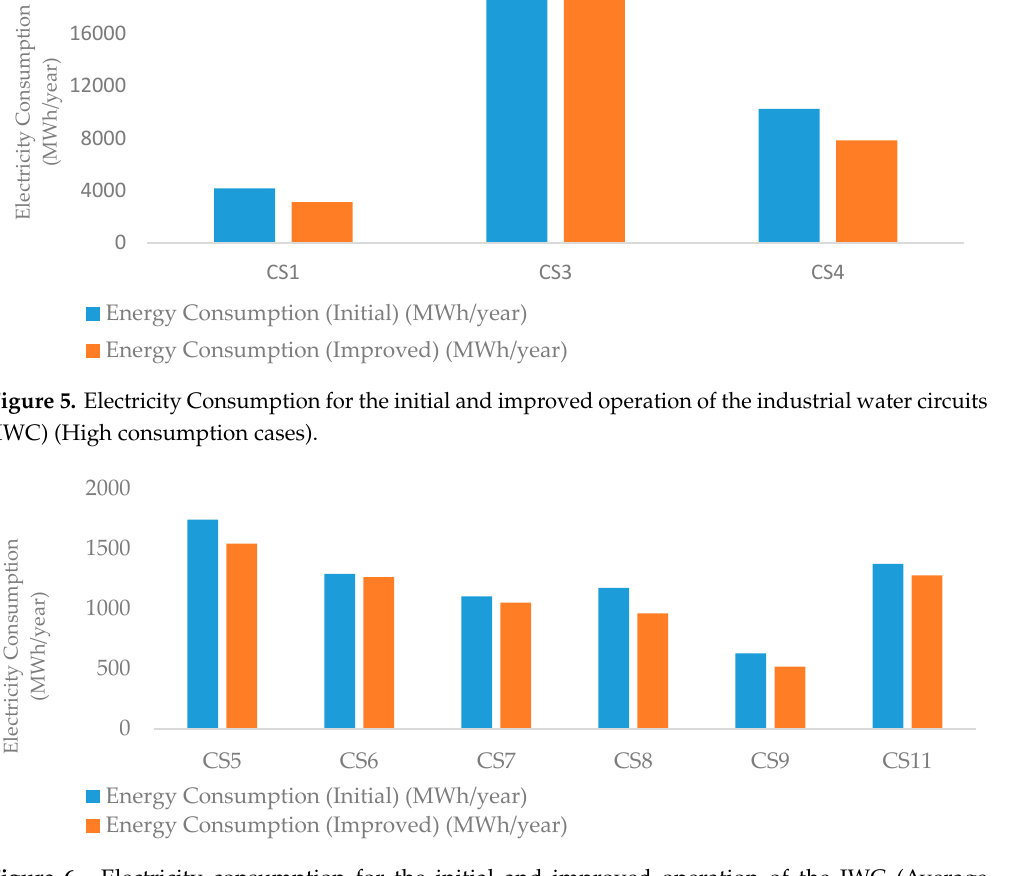
Figure 7. Electricity consumption for the initial and improved operation of the IWC (Low consumption cases). In the case ‐ studies with high electricity consumption (CS1 and CS4), appreciable savings have been achieved. On the other hand, the implementation of all the measures in CS3 has not allowed significant reductions of the energy consumption. The CS2 encompasses the circuit with the most